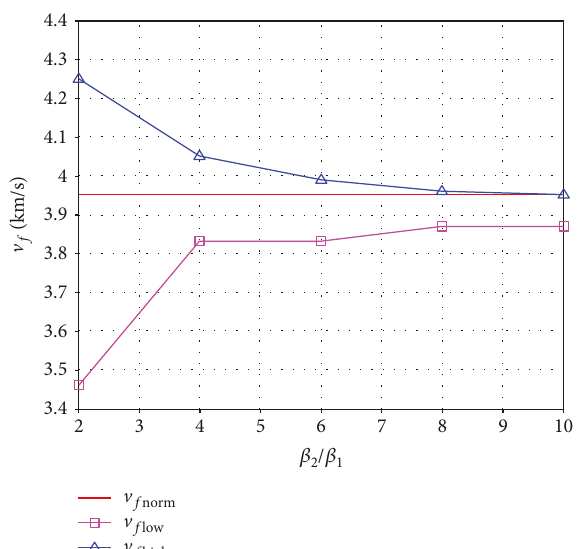
Figure 8: The boundary of terminal